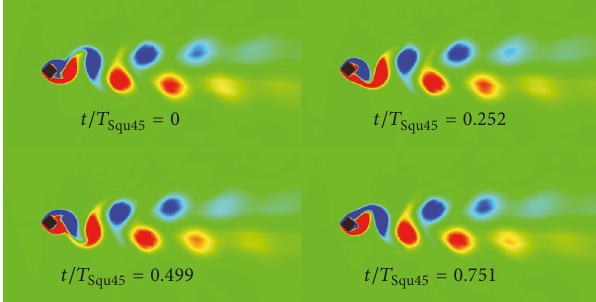
Figure 20: Vortex structures in synchronization region for 𝛼 = 45 ∘ .